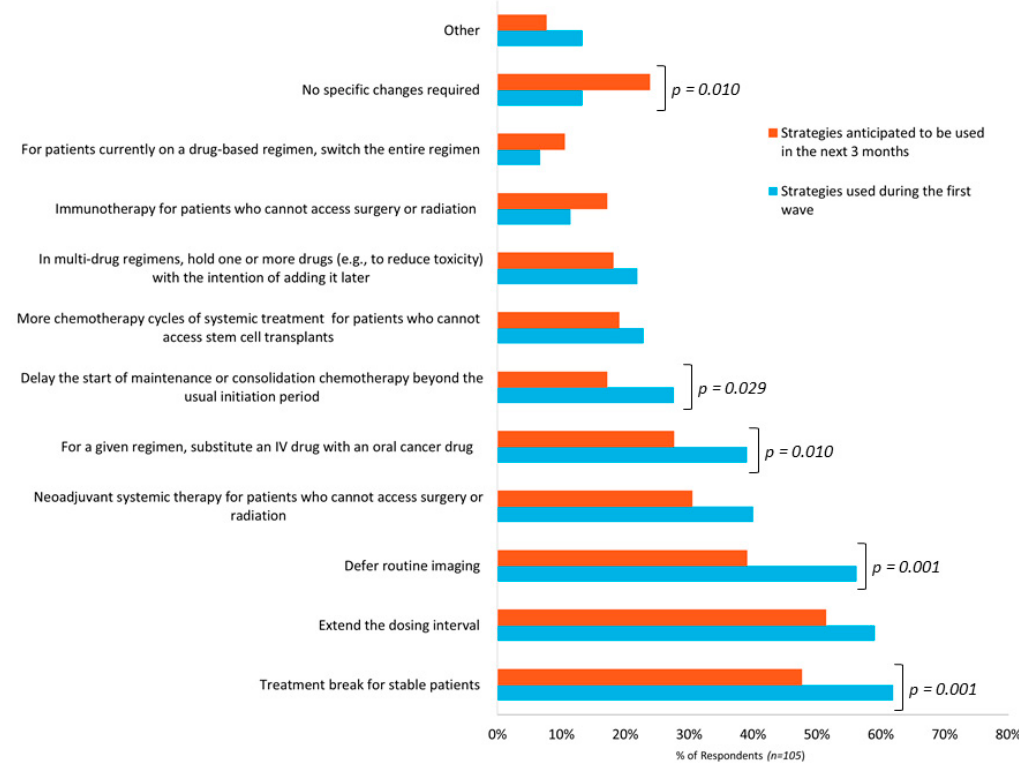
Figure 1. Frequency of strategies of used or anticipated to be used by respondents ( n = 105) to manage cancer patients during the initial wave of the COVID-19 pandemic and in the upcoming three months.